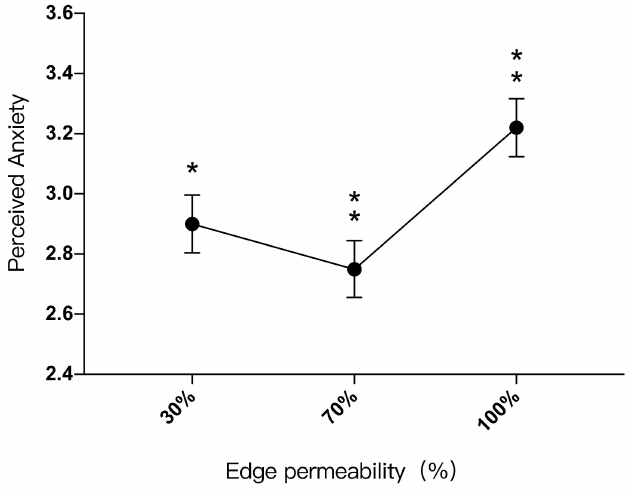
Figure 8. Impacts of different edge permeability levels on perceived anxiety, *: p < 0.05, **: p <